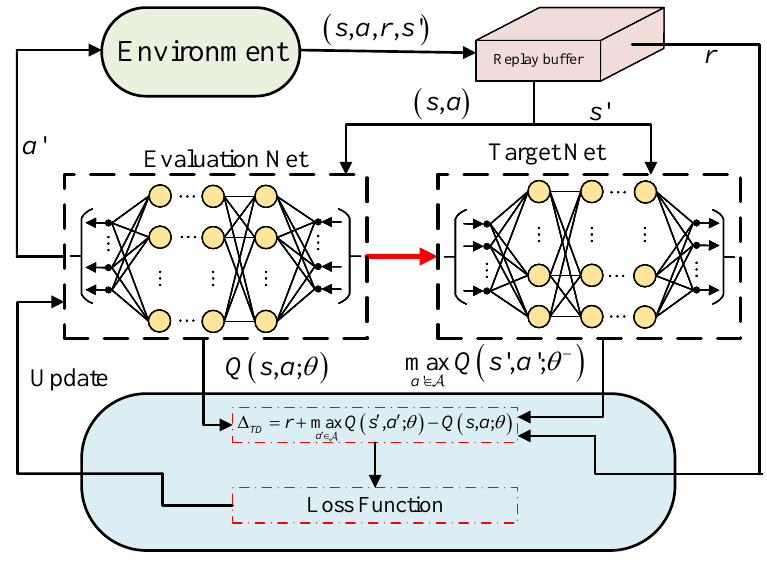
Figure 2. Schematic diagram of